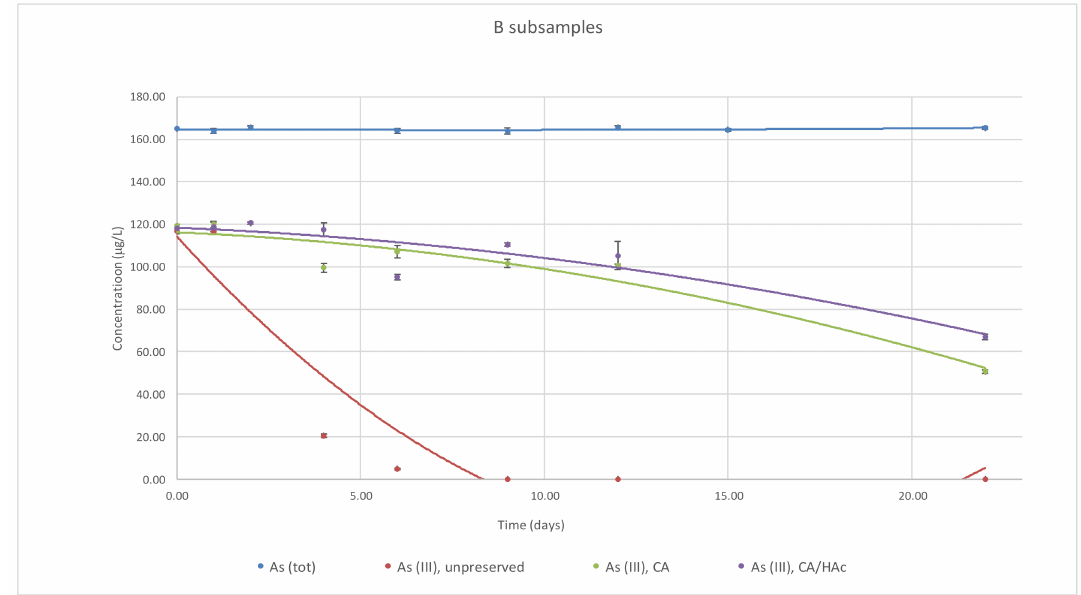
Figure 5. As(III) and As(tot) stability over time, dependent on the preservation treatment used—natural water sample